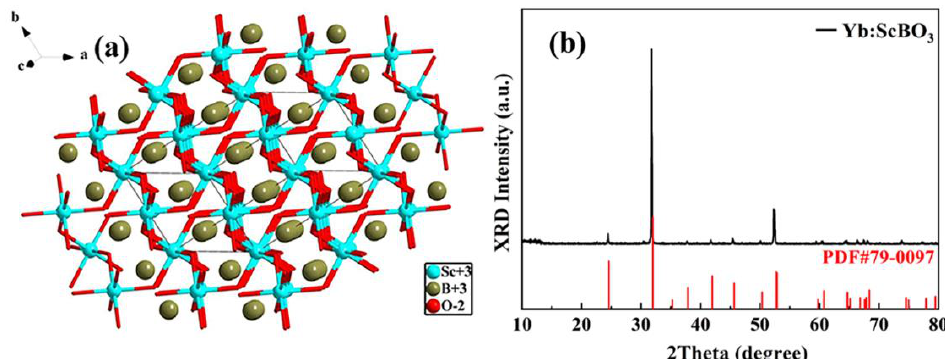
Figure 1. ( a ) Structural diagram of ScBO 3 and ( b ) comparison between X-ray powder diffraction pattern of standard PDF#79-0097 and Yb 3+ :ScBO 3 crystal [34].